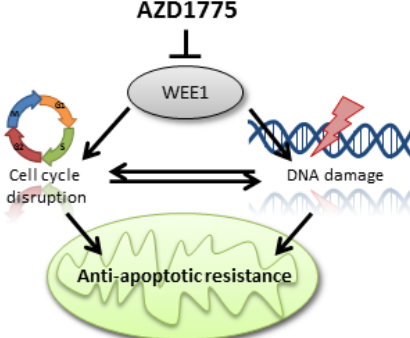
Figure 6. Proposed mechanism for the relation between inhibition of cell cycle regulator WEE1 and the resistance of apoptosis. As a result of WEE1 inhibition cells are able to prematurely enter mitosis, without proper repair of genomic aberrations or mutations. This elimination of the checkpoint at the transition from the G2-phase into the M-phase leads to continuous cell cycling and results in high levels of DNA damage that activate apoptosis pathways. To prevent apoptosis, cancerous cells become increasingly dependent on anti-apoptotic proteins such as BCL-2, MCL-1, BCL-XL, and BCL-W, which ensure survival under high levels of genomic stress.